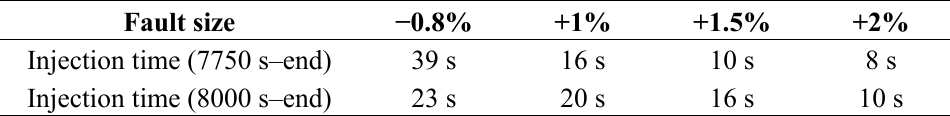
Figure 12. Voltage sensor fault diagnostic results under UDC test. ( a ) Generated residual r ; ( b ) Filtered residual r ; ( c ) Residual evaluation result S ( k ) using CUSUM; ( d ) Detected voltage sensor fault. Table 3. Detection time for voltage sensor fault under UDC